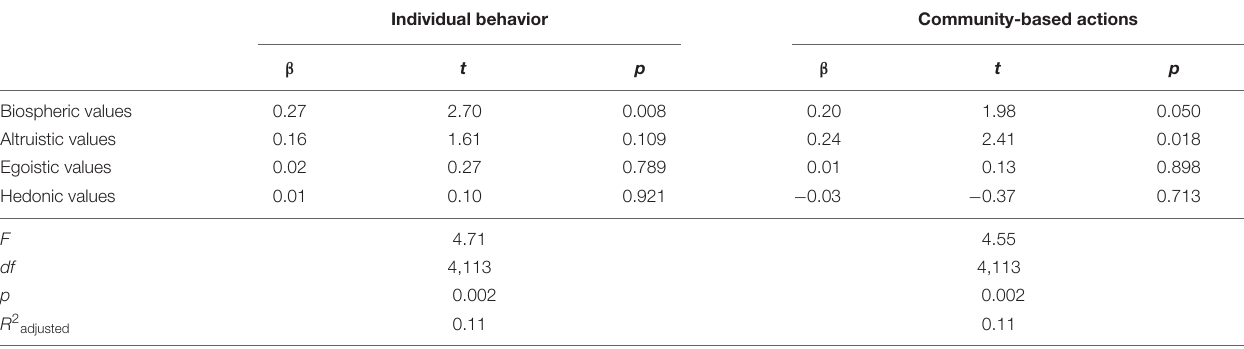
TABLE 2 | Regression models for self-directed social change actions (individual behavior and community-based actions).